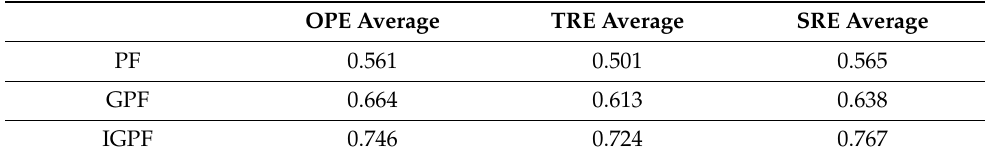
Table 2. OS comparison of the three